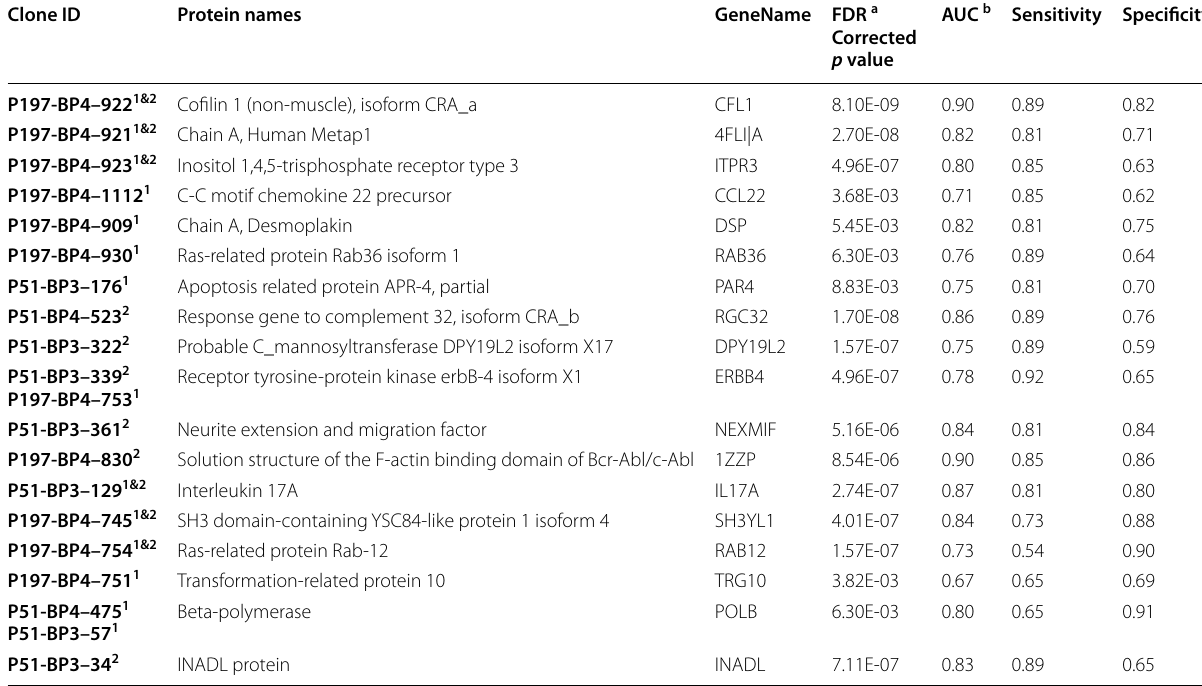
Clone ID: superscription 1&2 refers to the clone identified through option 1 or option 2, Protein name, NCBI gene name, a False discovery rate, b Area under the curve